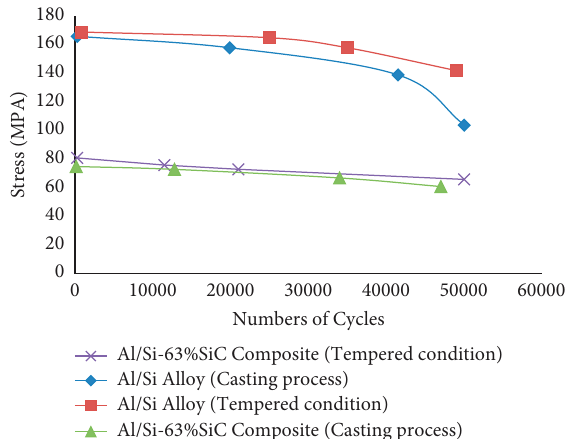
Figure 6: S-N curve of Al-Si alloy and Al-Si/63% SiC composite at various